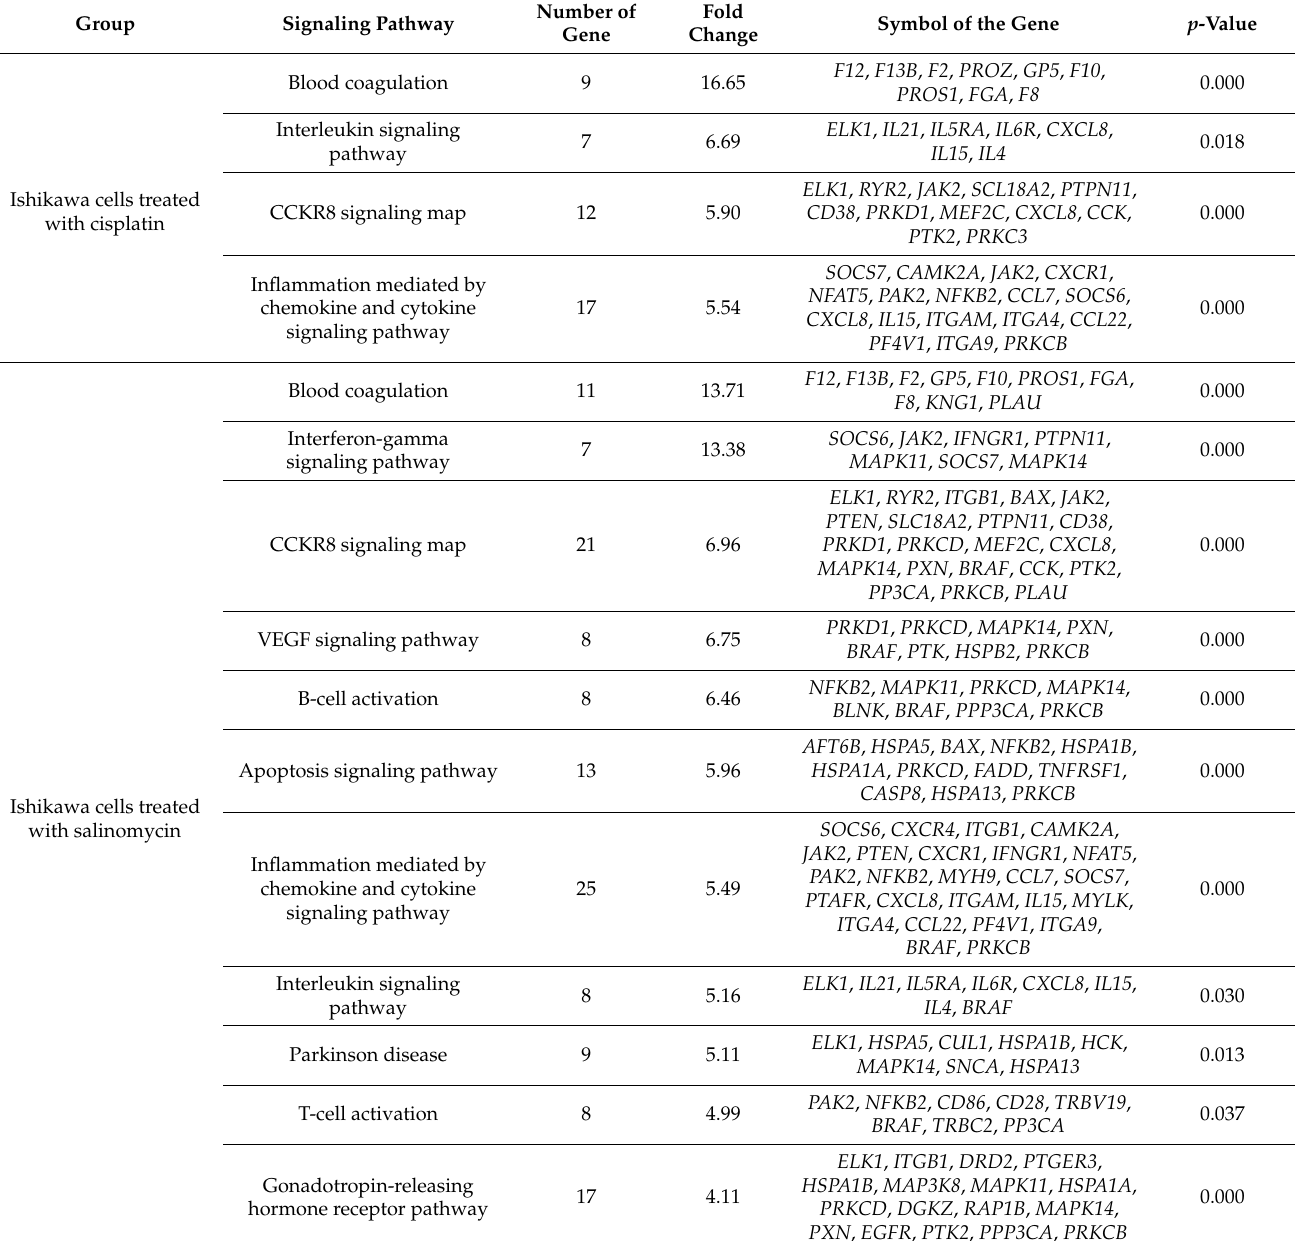
Table A2. Signaling pathways modulated by genes related to the phenomenon of oxidative stress in Ishikawa cells exposed to cisplatin or